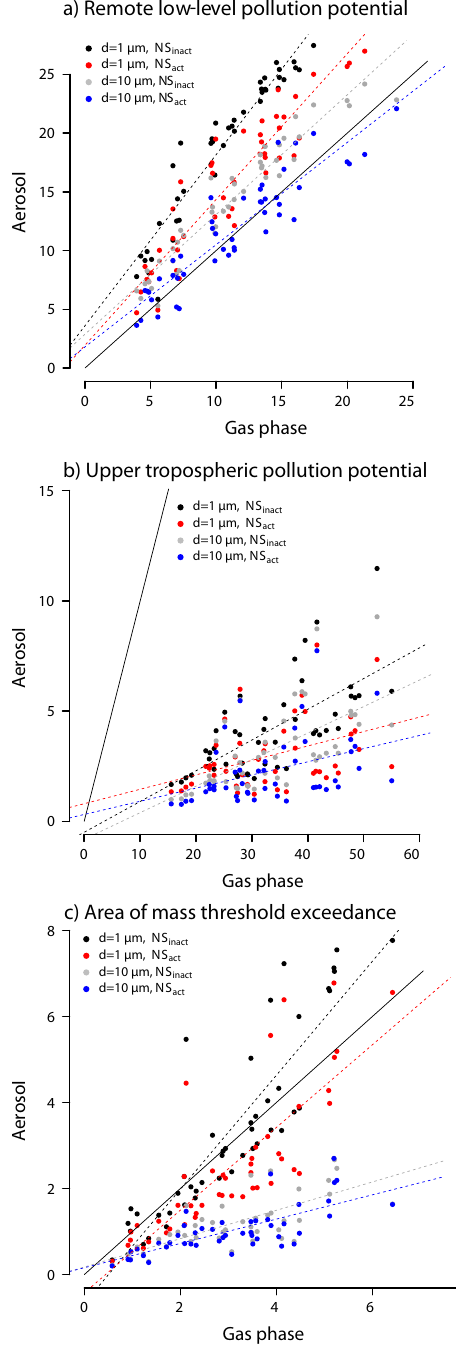
Fig. 4. Comparison between gas-phase and aerosol pollution po- tentials: ELR 1km (top panel, in%), E UT (middle panel, in %), and A 10 (bottom panel, in 10 6 km 2 ). Colored dots represent different aerosol properties: black = NS inact 1.0µm, red = NS act 1.0µm, gray = NS inact 10.0µm, and blue = NS act 10.0µm. These aerosol tracers are considered to cover the aerosol spectrum of this study and other tracers are neglected to keep lucidity. The solid black lines represent the bisecting line, the colored dashed lines the regression lines (see equations in the